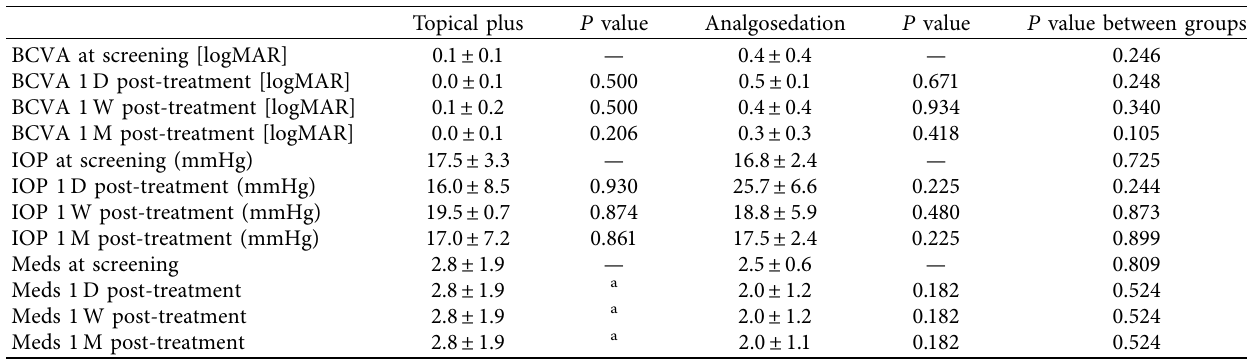
Table 4: Change in visual acuity, intraocular pressure, and